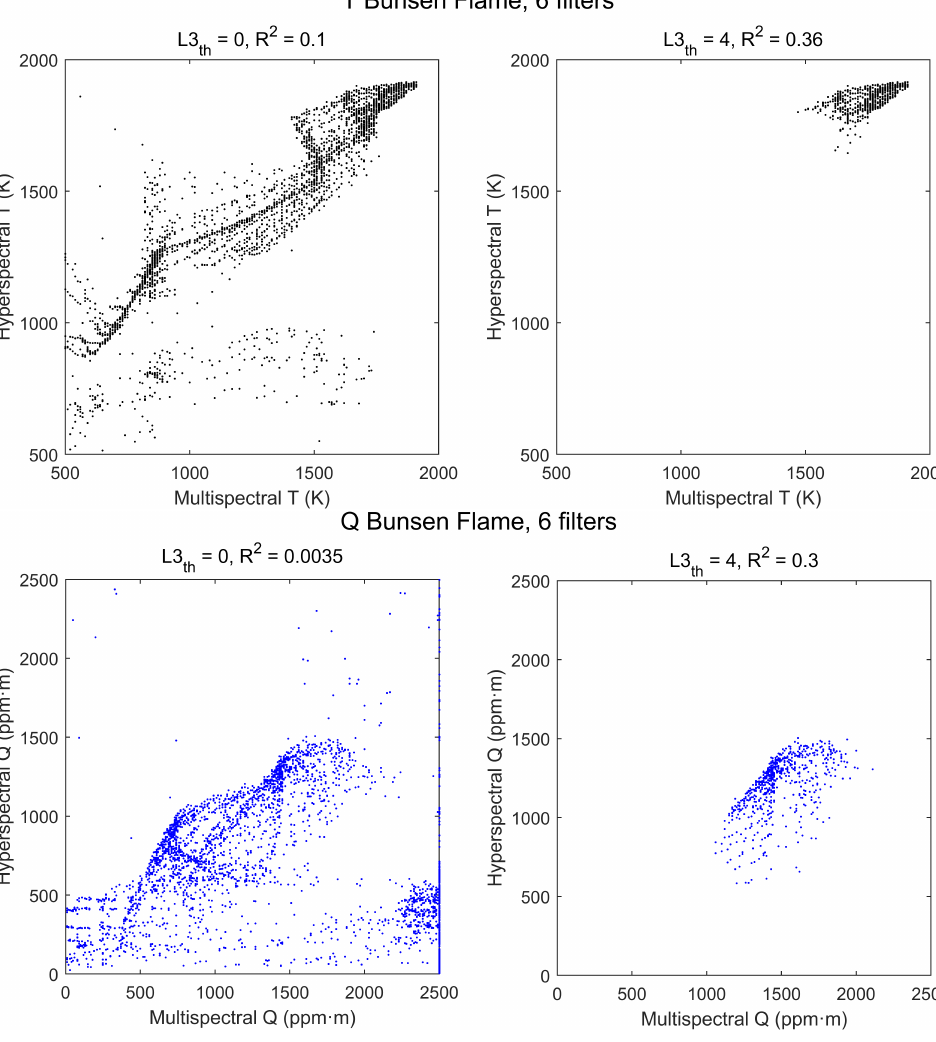
Figure 11. Scatterplots of hyperspectral vs. multispectral retrieved values of T ( top row ) and Q ( bottom row ) for a Bunsen flame. Each point corresponds to a pixel, with no radiance threshold ( left column ) and with threshold L3 th = 4 W/m 2 · sr · cm − 1 ( right column